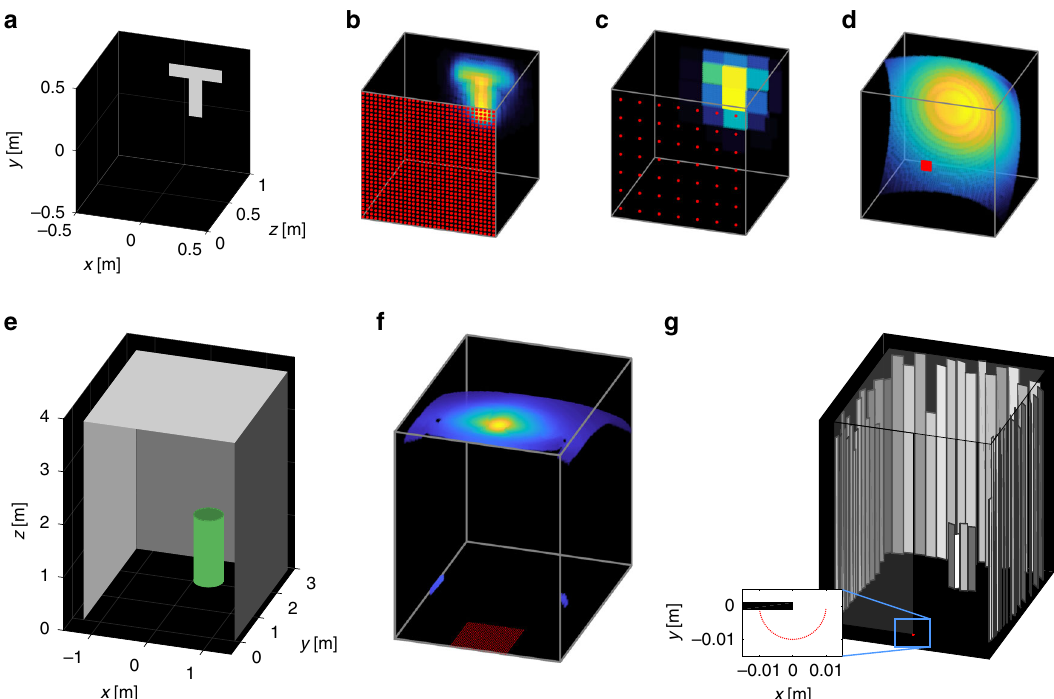
Fig. 4 Conventional NLOS limitations. Simulations of confocal measurements for a planar, T-shaped object ( a ) highlight the resolution and fi eld-of-view limitations of conventional NLOS methods. Laser illumination positions are shown as red dots throughout. Reconstructions using the f – k migration algorithm 12 ( b – d ) show degradation as the aperture sizes and numbers of measurement points decrease. Hence, large-scale scenes ( e ) yield poor reconstructions ( f ), even from an aperture size of (1 m) 2 . By taking advantage of existing vertical edges ( g ), ERTI is still able to accurately reconstruct large scenes despite a small aperture and few